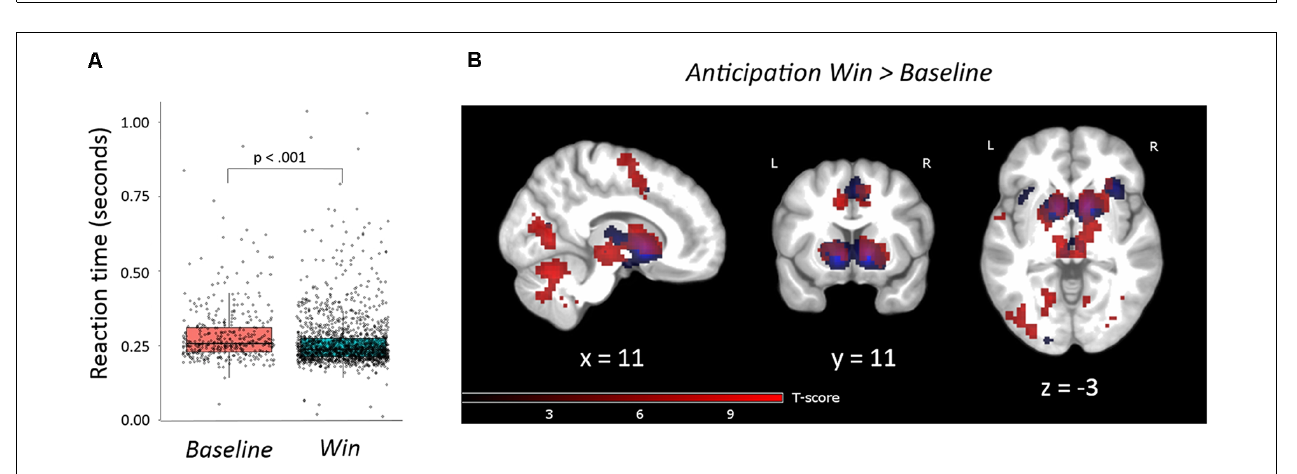
FIGURE 3 | (A) Reaction times for win trials were statistically shorter than for baseline trials (beta = − 0.03, t (1936) = − 5.72, p < 0.001). The linear mixed-effects model was statistically significant ( F = 32.70, p < 0.001). (B) Task activations of contrast anticipation Win vs. Baseline . FWE, p = 0.05, clusters > 20 voxels. Activations are overlaid on an average T1 image based on our 29 participants. Task activations (red color) in this study overlap with activations reported by Oldham and colleagues (blue color; Oldham et al., 2018). For the exact location of activations, see Supplementary Table S3 .